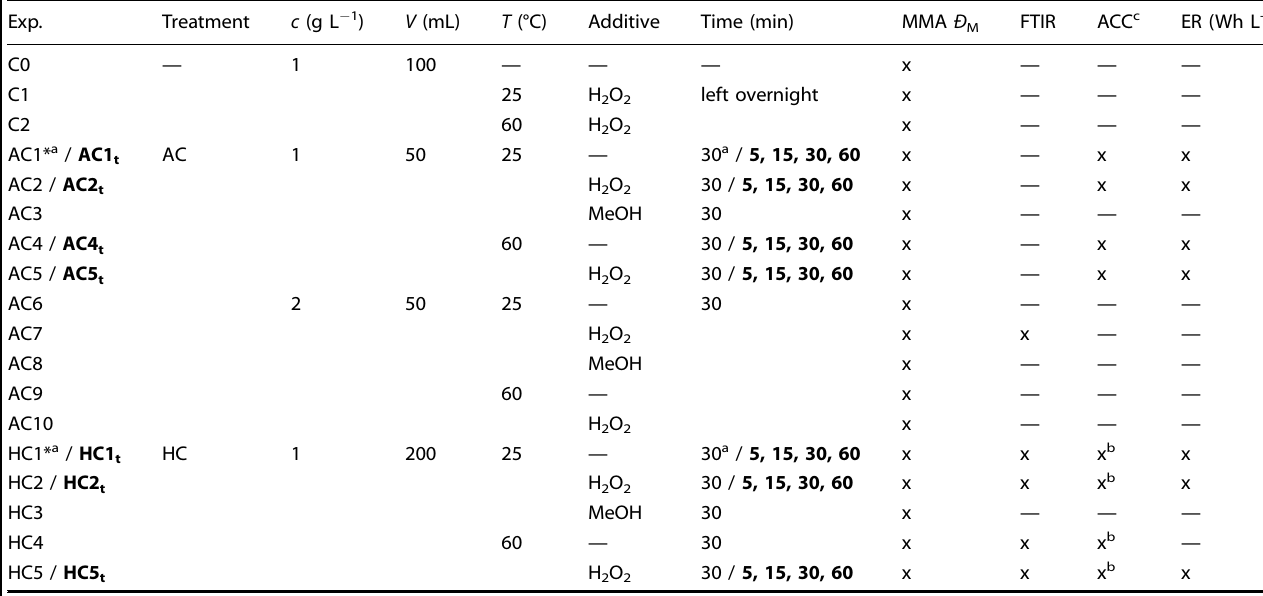
Table 1. Overview of experiments, experimental conditions and analysis performed during this study.